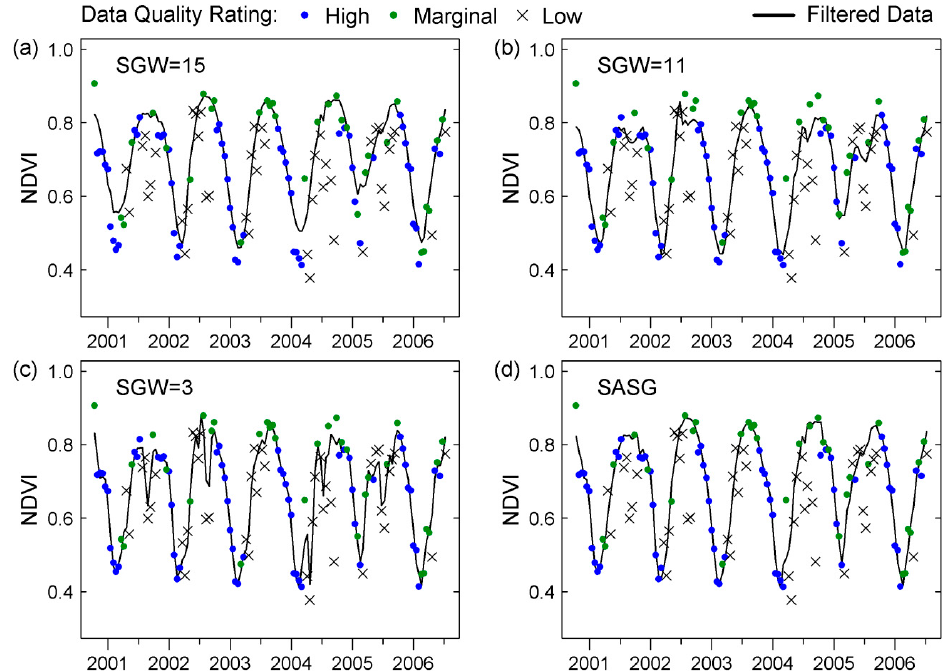
Figure A2. Example of filtered data in dry deciduous forest. Standard Savitsky–Golay filter with window sizes of 15 ( a ); 11 ( b ); and three ( c ); and the Seasonally Adjusted Savitky–Golay (SASG) filter ( d ). Wider window sizes are better suited to poor quality data during the wet season, while narrow windows are better suited to higher quality data available during the dry season. The SASG preserves the advantages of both. SGW = Savitsky–Golay window size.